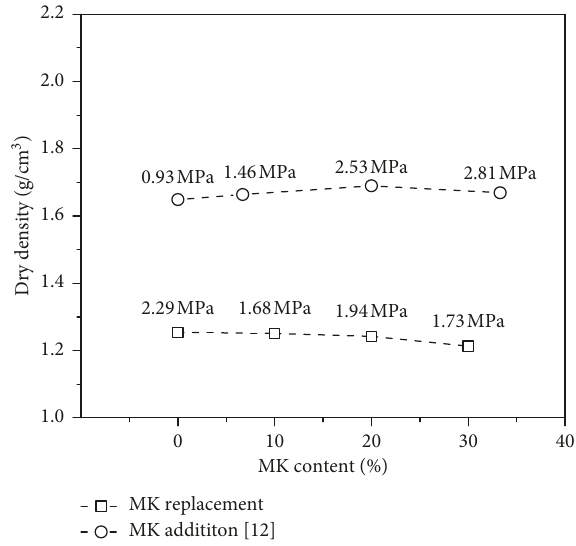
Figure 3: Dry density of MK-blended cement-treated soil mixtures cured for 28days.